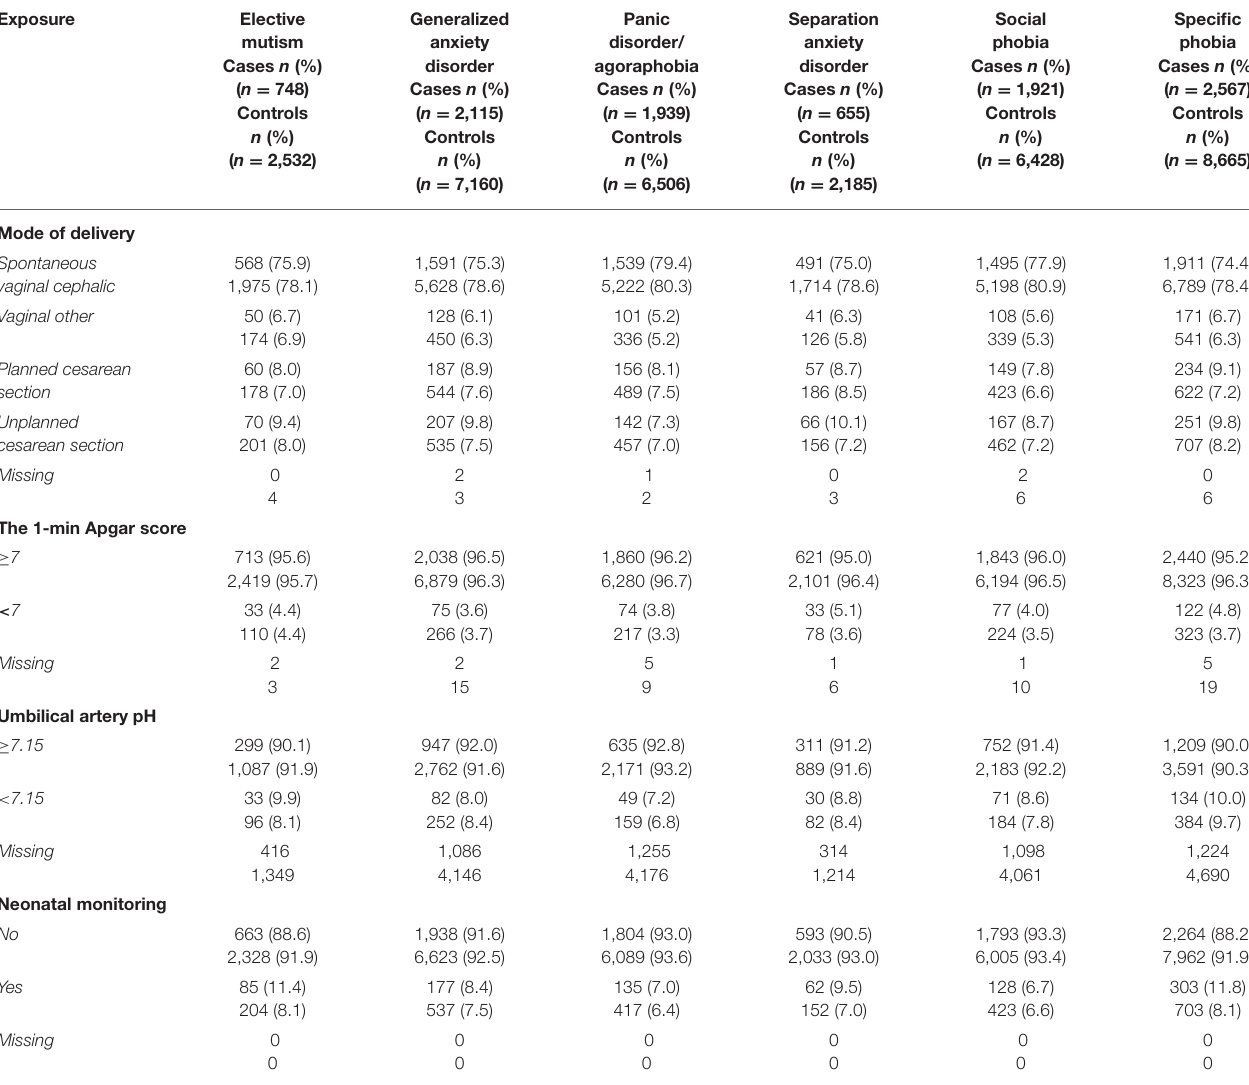
TABLE 2A | Frequencies of the exposure variables in the cases with specific anxiety disorders and the controls.